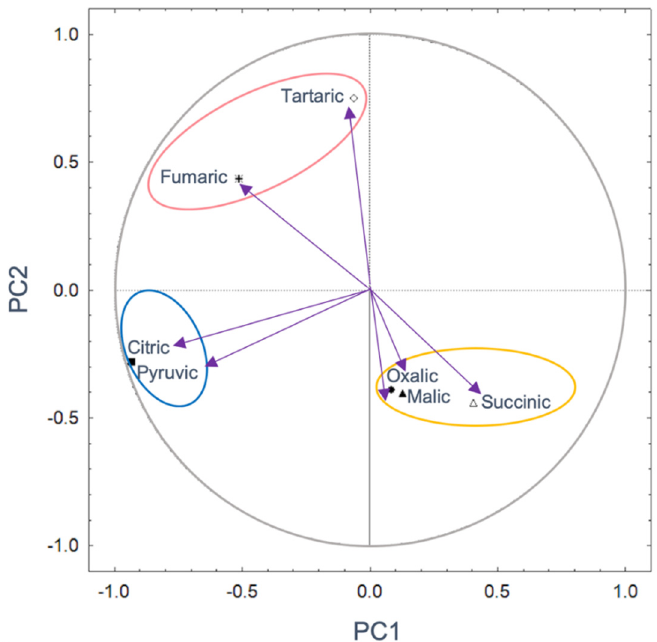
Figure 5. Principal components based on the correlation of the kind and amount of organic acid without considering the soil mineralogy. PC1 31.32%; PC2 20.42%. Significant parameters are indicated by continuous lines ( P < 0.05). The ellipses show groups of communities of OAs.